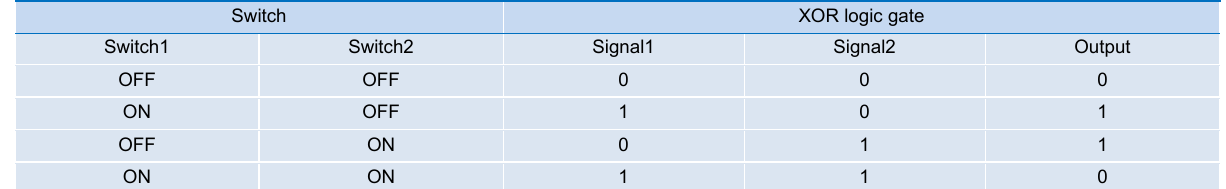
Table 1 | The “ON” and “OFF” state of the all-optical switch and the true value of the XOR logic gate in the integrated photonics